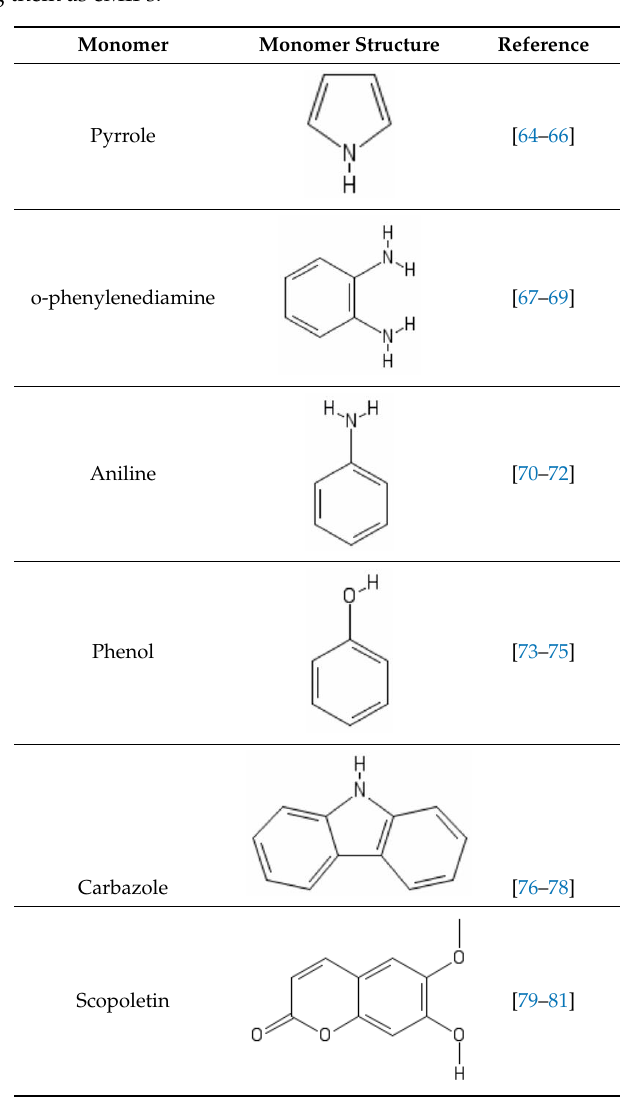
Table 1. Commonly used monomers in the formation of eMIPs alongside their structures and selected references utilising them as eMIPs.